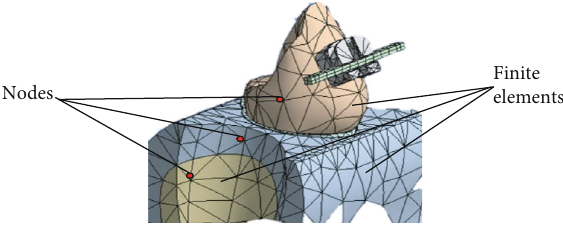
Figure 4: Finite elements of low bio fi delity models. The low bio fi delity of the biomodels causes the results to be far from those obtained in reality.